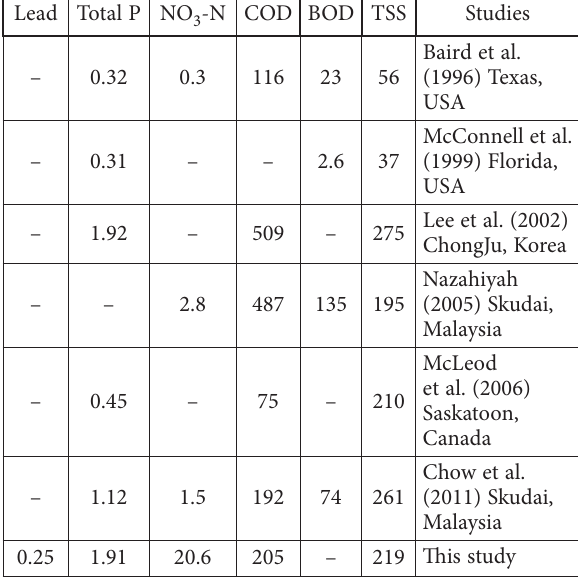
Table 3. Comparison of site mean concentrations (SMC, mg/L) Lead Total P NO 3 -N COD BOD TSS